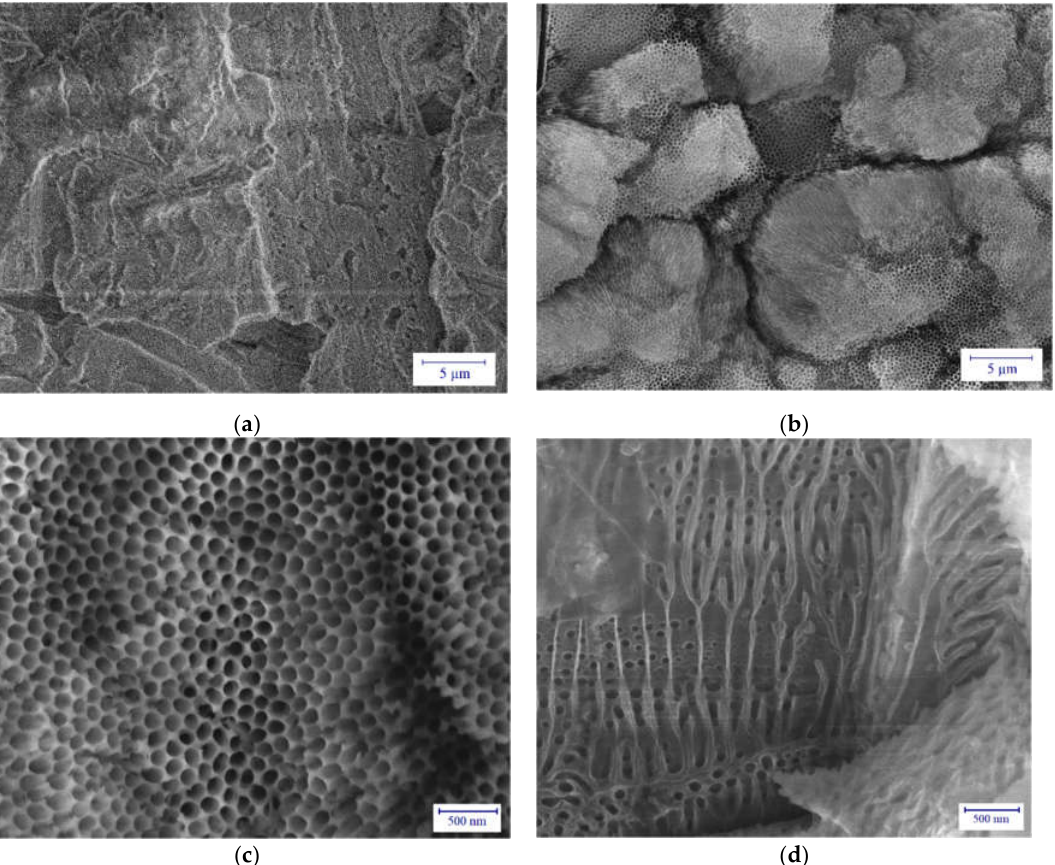
Figure 5. SEM images on the microstructure of the anodized layers, showing ( a ) a compact surface after anodizing at j = 1 A/dm 2 at 1 h, ( b , c ) beehive-like structure formed at j = 6 A/dm 2 for 1 h in different magnifications and ( d ) the corresponding pipe-structure in the cross-section of the anodized layer shown in ( b , c ).